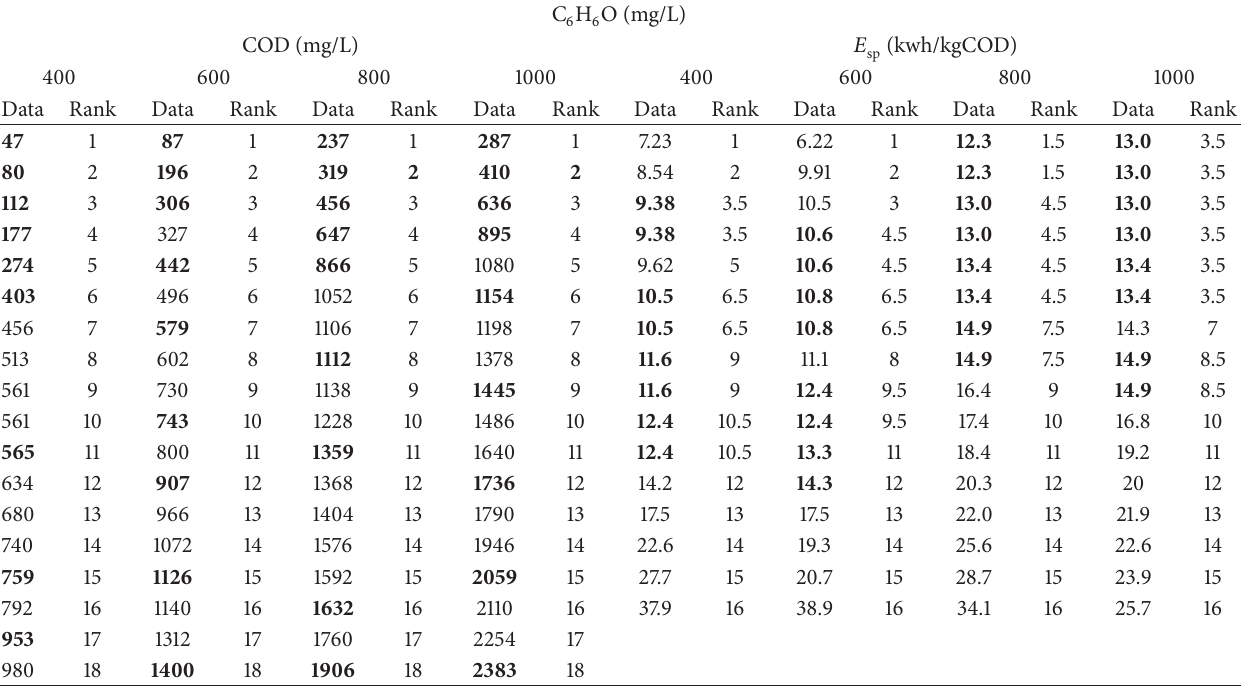
Figure 6: Variation of phenol concentration in different salinity wastewater over time. (a) Variation of remaining phenol concentration over time. (b) Removal rate of phenol over time. Table 2: Theoretical value and measured data and orders of